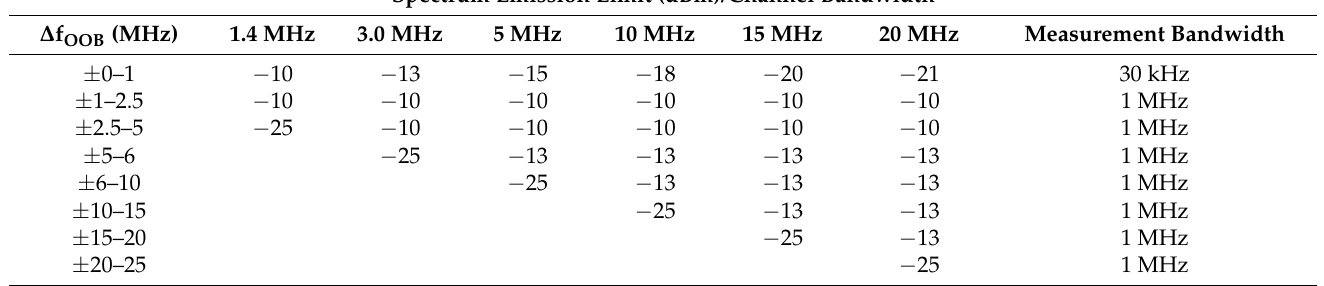
Table 3. Spectrum emission mask.